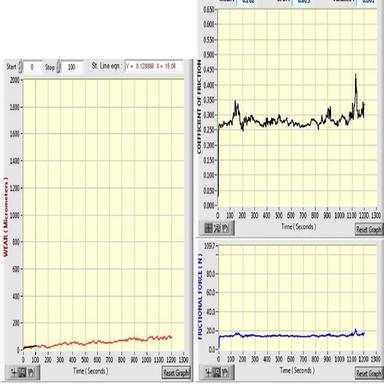
Variation of Wear rate, coefficient of force and frictional force of Al-SiC-MgO2 FGM with respect to time at 55 N, 473 rpm and 30 min wear time.